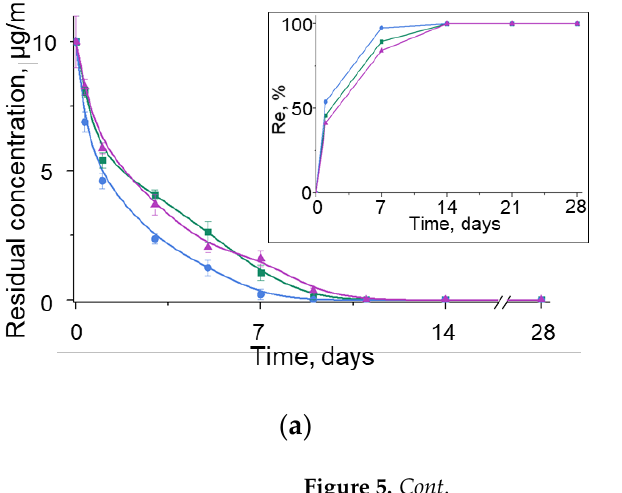
Figure 4. UV-Vis absorption spectra of benzylpenicillin ( a ), tetracycline ( b ), and ciprofloxacin ( c ). The kinetics of change in the antibiotic concentration in the BN suspension was stud- ied for three different initial concentrations (10, 20, and 40 µg/mL) at a temperature of 24°C and pH = 6 for 28 days (Figure 5). The amount of antibiotic adsorbed on the surface of BNNPs per unit time depended on the solution ’s initial concentration as follows: the higher the initial antibiotic concentration, the lower the adsorption rate. When testing ben- zylpenicillin and tetracycline at initial concentrations of 10 and 20 µg/mL, 50% of the an- tibiotic was adsorbed in the first 2 days. At a concentration of 40 µg/mL, the adsorption time increased to 4 days. In the case of ciprofloxacin, 50% of the antibiotic was adsorbed on days 2, 4, and 6 at concentrations of 10, 20, and 40 µg/mL, respectively. At an initial concentration of 10 μg/mL, 100% adsorption was observed on the 9th (tetracycline) and 11th (benzylpenicillin and ciprofloxacin) days. With an increase in the initial concentra- tion to 20 μg/mL, the time for complete adsorption increased to 14 (tetracycline) and 21 (benzylpenicillin and ciprofloxacin) days. At the maximum studied concentration of 40 µg/mL, only tetracycline and benzylpenicillin showed 100% adsorption on the 28th day, while with the use of ciprofloxacin, the sorption process continued.